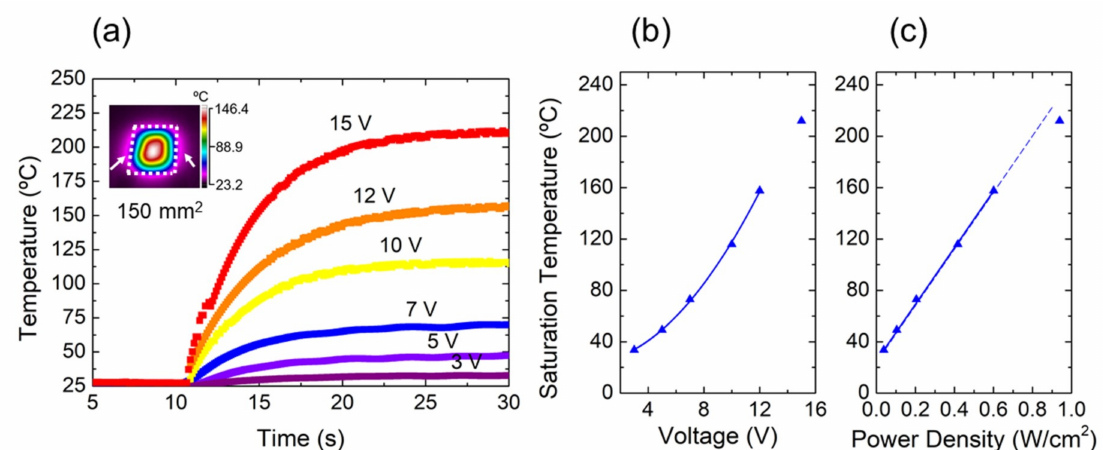
Figure 3. Temperature profiles of a 150 mm 2 LrGO-based heater on Kapton ® . ( a ) Time dependent characteristic of the heater. Inset shows a thermal image of the LrGO heater (arrows indicate the contacting sides). ( b ) Saturation temperature as a function of the voltage applied. ( c ) Saturation temperature as a function of the input power